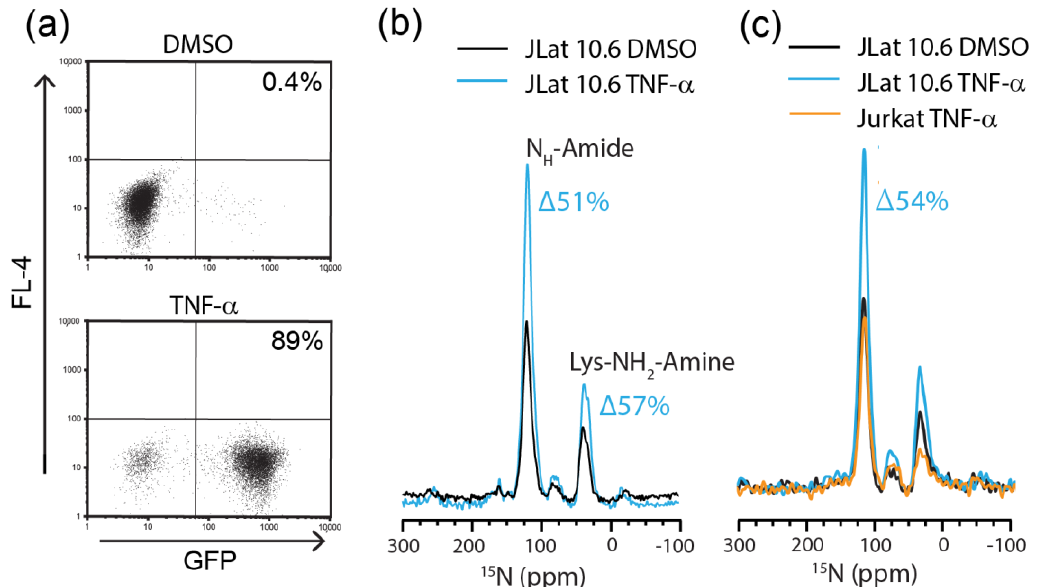
Figure 3. Characterization of HIV production in JLat 10.6 cells by MAS-DNP and flow cytometry. ( a ) Flow cytometry of the GFP expression by JLat 10.6 cells. Percentages in the plots indicate the proportion of total live cells that are GFP + (bottom right quadrant). ( b ) 15 N cross-polarization magic angle spinning (CPMAS)-DNP spectra of 1% DMSO (black line)- or TNF- α (blue line)-treated 15 N-labeled JLat 10.6 cells. ( c ) 15 N CPMAS-DNP spectra of Jurkat (orange line) and JLat 10.6 cells stimulated with TNF α (blue line) or the DMSO control (black line). Spectra were acquired at 7.05 T and 95 K with 197.674 GHz microwave irradiation, 4.5 kHz MAS and 2048 transients. ( b , c ) are independent experiments.